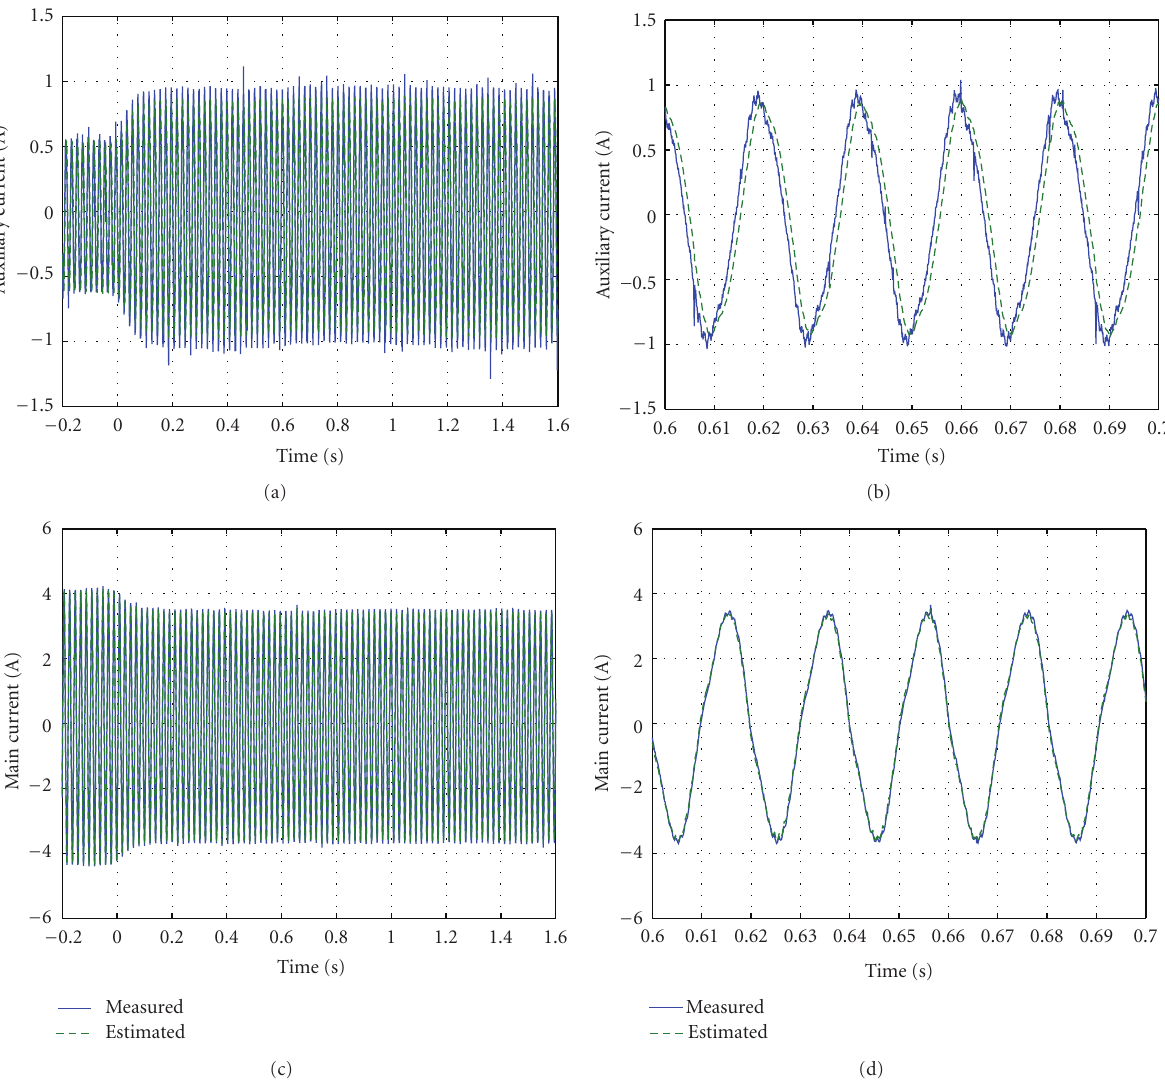
Figure 15: Measured and estimated currents of the SPIM when the rated mechanical load is removed (experimental results): (a) auxiliary winding i sα , (b) details of i sα , (c) main winding i sβ , (d) details of i sβ